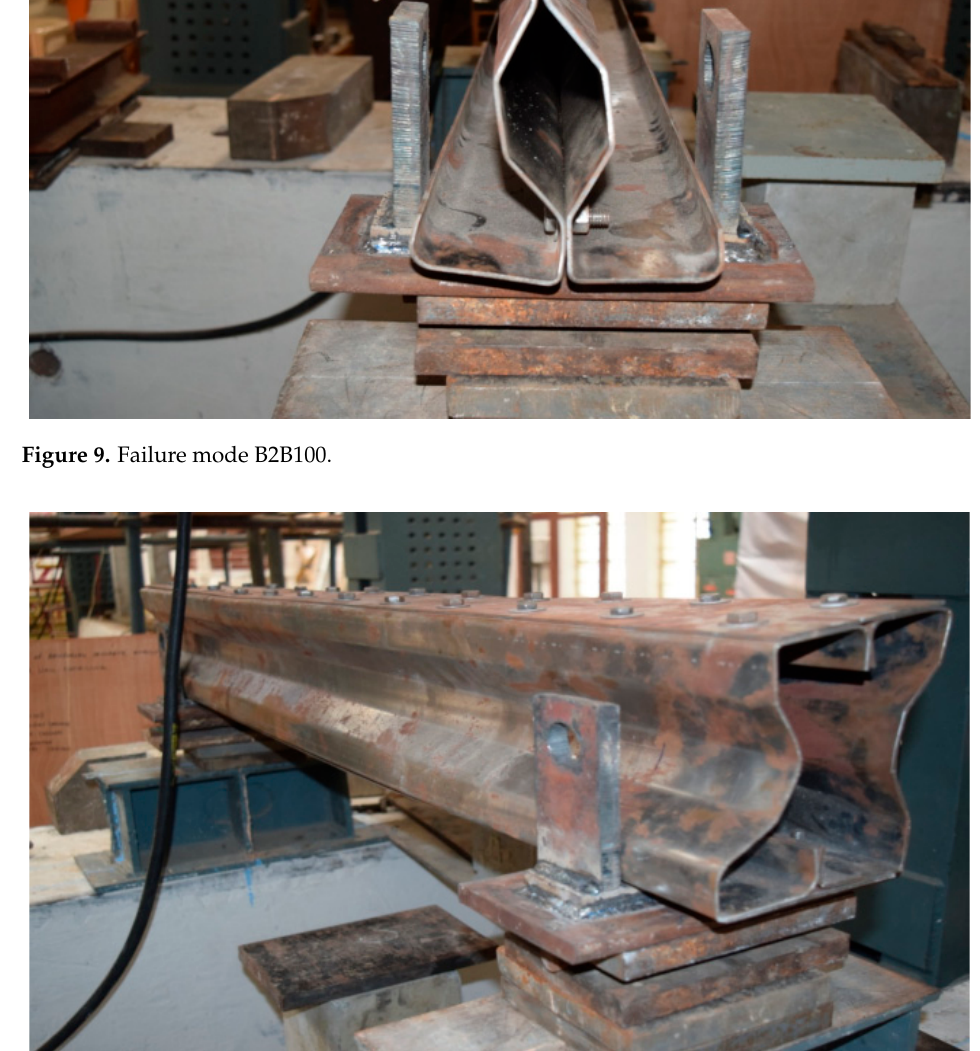
Figure 11. The failure mode of B2B157. Figure 12. Tested specimens. 3.3. Load–Deflection Behavior